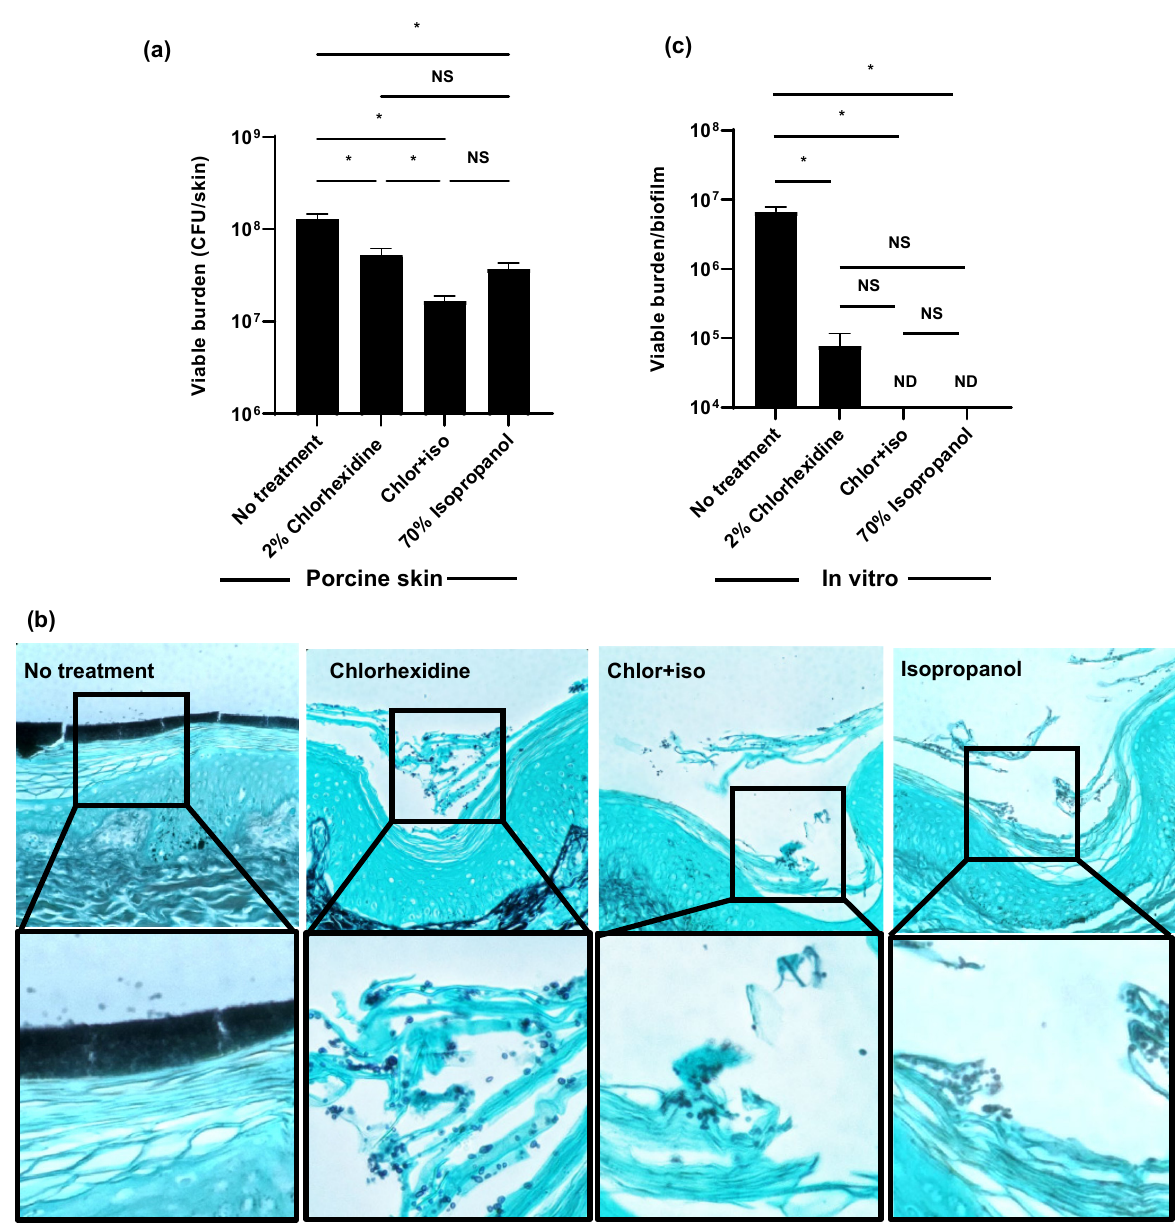
Figure 2. Isopropanol augments the activity of chlorhexidine for C. auris skin decolonization: ( a , b ) C. auris was applied to the surface of full-thickness porcine skin samples and samples were incubated for 24 h to promote colonization. Chlorhexidine gluconate (2%), chlor+iso (2% chlorhexidine + 70% isopropanol), or isopropanol (70%) was applied for 1 h daily for 3 days. The impact on colonization was assessed by viable burden ( a ) and histopathology with Grocott’s methenamine silver staining ( b ). ( c ) C. auris biofilms were propagated in synthetic sweat media in 12-well plates for 24 h. Antiseptics were applied for 1 h and the remaining viable burden was determined by plating. ND = not detected (CFU < 10 colonies). Data were analyzed by one-way ANOVA with Holm–Sidak multiple comparison among groups, * p < 0.05, NS = not significant, standard error of the mean shown, n = 3.